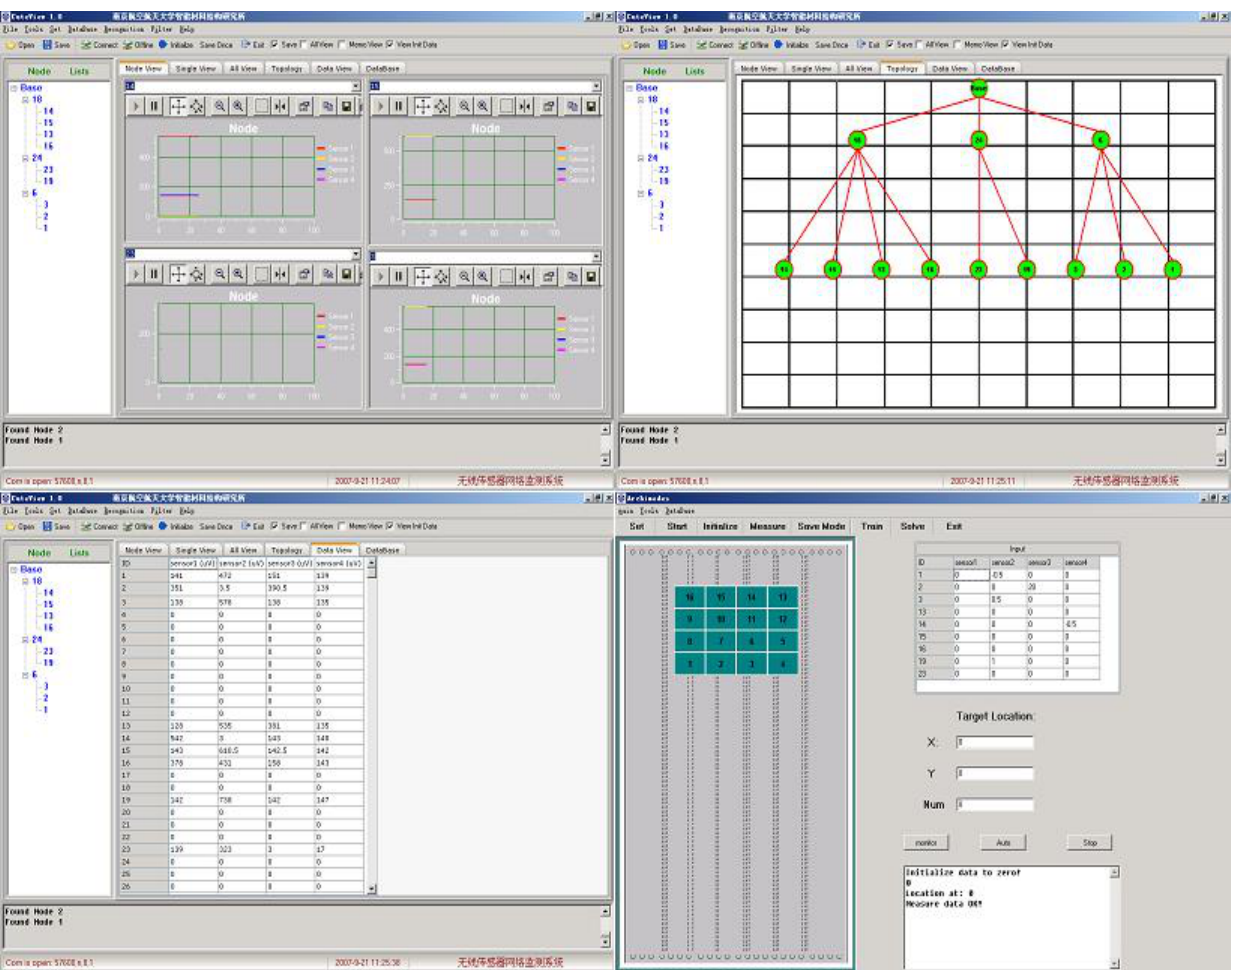
Figure 11. The WSN application layer interface for